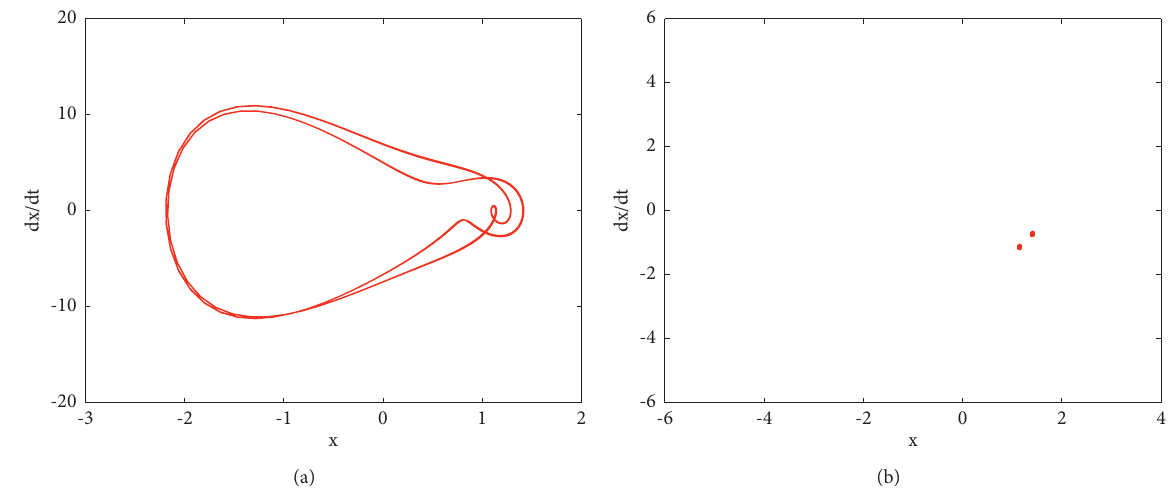
Figure 3: Phase portrait and Poincar´e cross section diagram of the system at F � 64.70 and τ � 1.2. (a) Phase portrait. (b) Poincar´e cross section diagram ( c � 0.5, c 1 � 30, c 2 � 20, μ � 0.001, k 1 � 10, and ω �